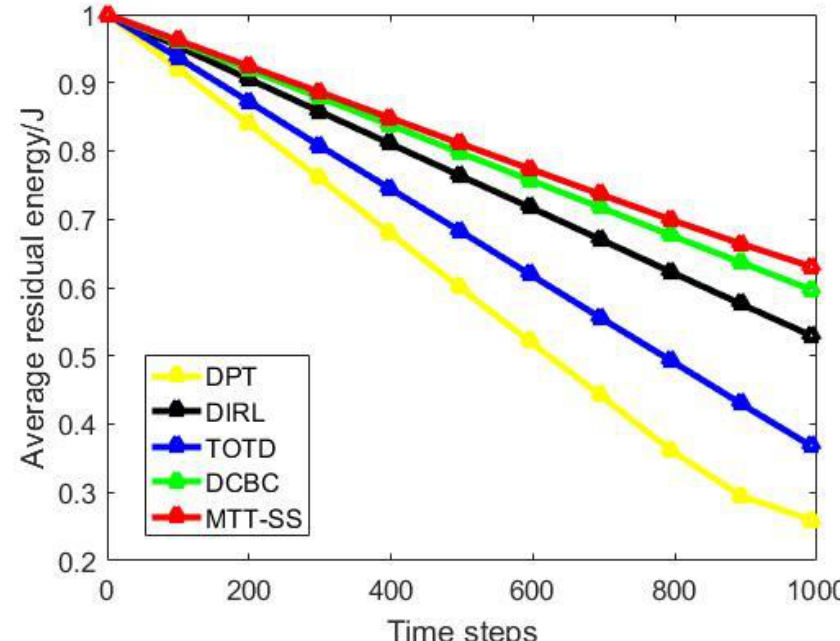
Figure 7. Average residual energy.